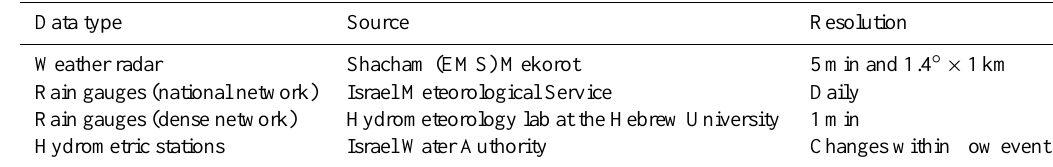
Table 1. Summary of data sources and resolutions used in this